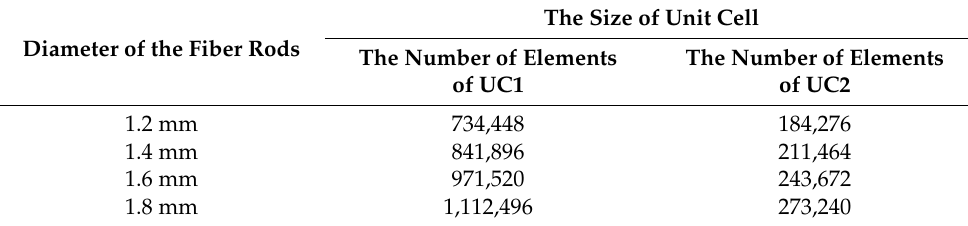
Table 3. The number of elements of UC1 and UC2 with carbon fiber rods of different diameters. Diameter of the Fiber Rods